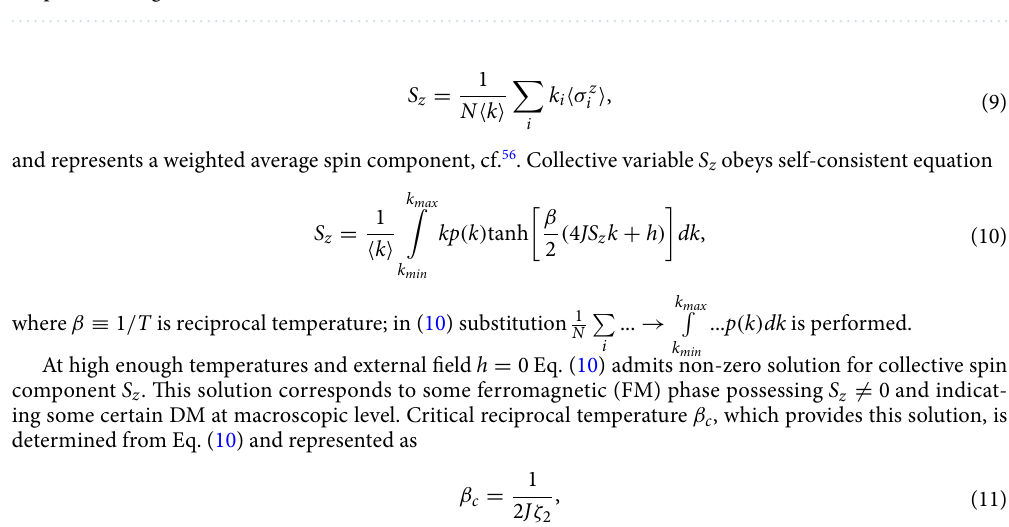
ζ 4 on degree exponent γ for k min ≡ 1 and different values of γ . Both figures =